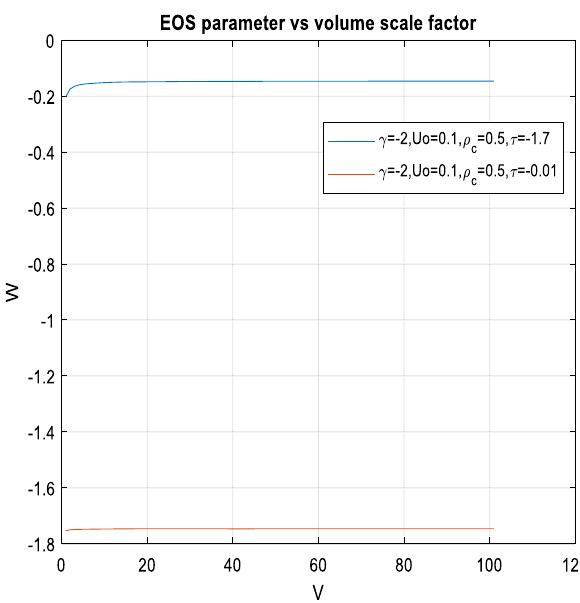
Fig. 8 Graph for EOS parameter; γ = − 2 ; U 0 = 0 . 5 ; τ = − 1 . 7 an τ = − 0 . 01